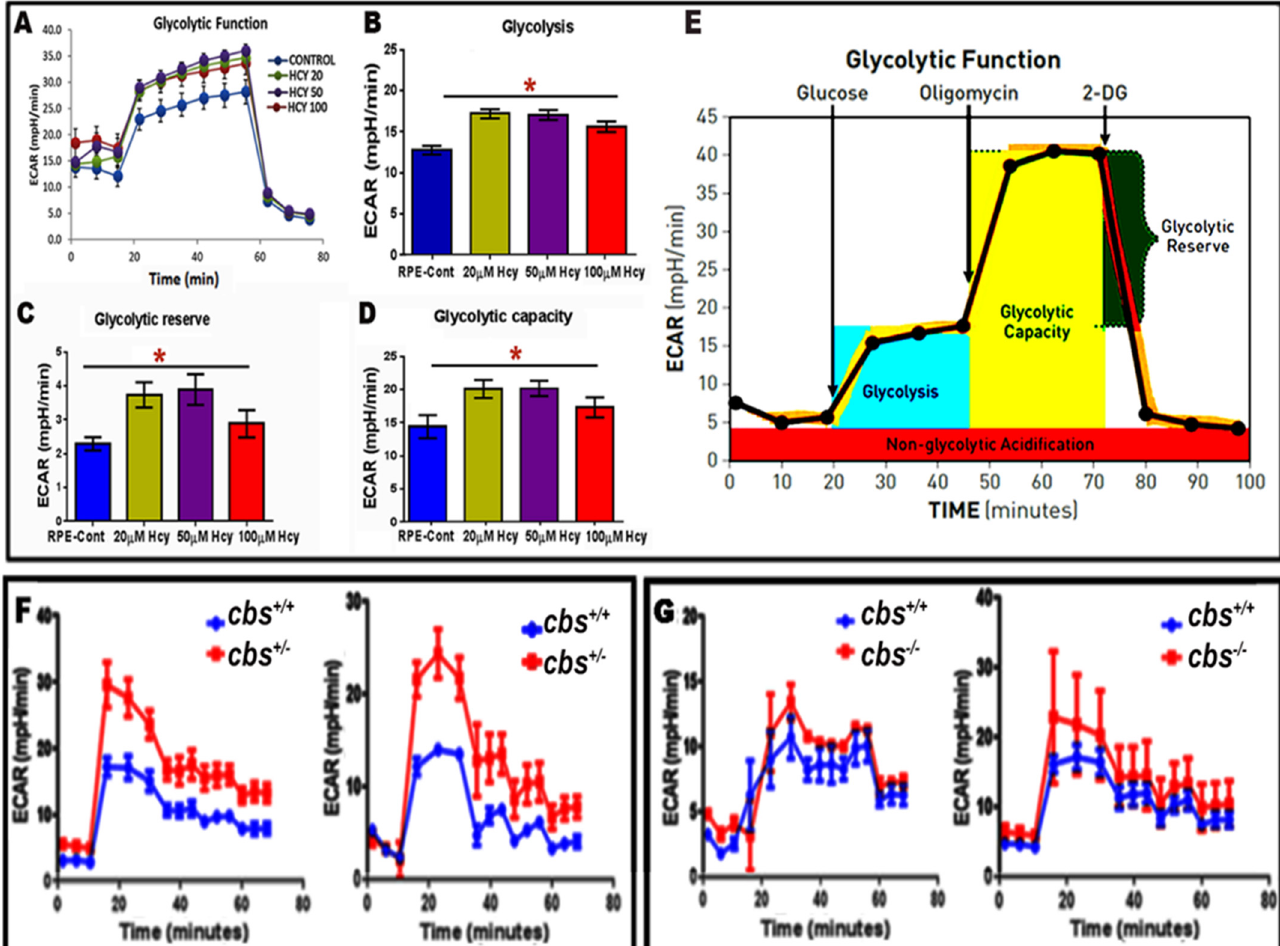
Figure 5. Seahorse analysis evaluation of glycolysis under HHcy. ( A ) ECAR was measured with an XFe96 extracellular flux analyzer in ARPE cells treated with different concentrations of Hcy (20, 50, and 100 µ M), showing that ECAR was significantly elevated in Hcy-treated ARPE cells compared to control untreated cells. ( B ) ECAR representative analysis showing significant elevation of glycolysis in Hcy-treated ARPE cells compared to control untreated cells. ( C ) ECAR glycolytic reserve analysis showing significant elevation of glycolysis reserve in Hcy-treated ARPE cells compared to control untreated cells. ( D ) ECAR glycolytic capacity analysis showed significant glycolysis capacity elevation in Hcy-treated ARPE cells compared to control untreated cells. ( E ) Diagram showing the stages of glycolysis as evaluated in RPE cells ( A – D ) and mice retina ( F , G ). ( F , G ) Replicate of ECAR measured with an XFe96 extracellular flux analyzer for retinas isolated from mice model of elevated Hcy (wild-type cbs +/ + , cbs +/ − and cbs − / − ), showing activation of glycolysis parameters in both the cbs +/ − and cbs − / − compared to wild-type cbs +/ + . * p < 0.05 as compared to RPE-control.